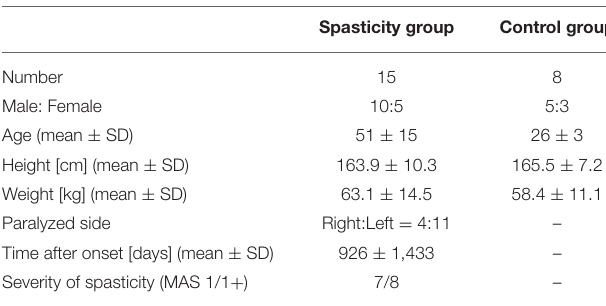
TABLE 1 | Demographic variables.